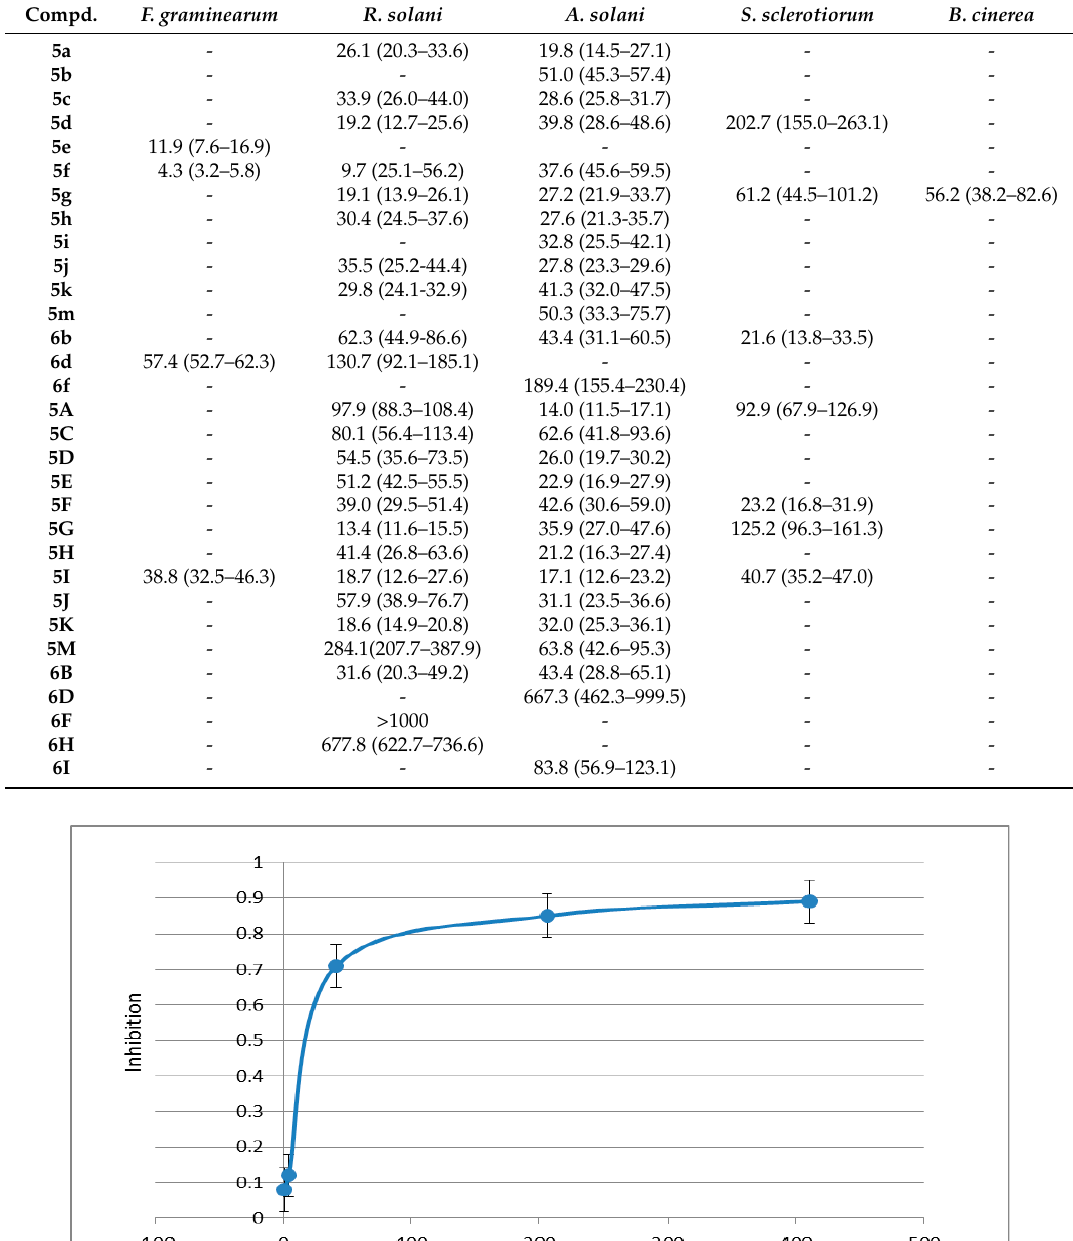
Table 2. The EC 50 (µM) values with 95% confidential interval in parenthesis of compounds 5 and 6 against different phytopathgens for the compounds with more than 70% inhibition rates in Table 1.